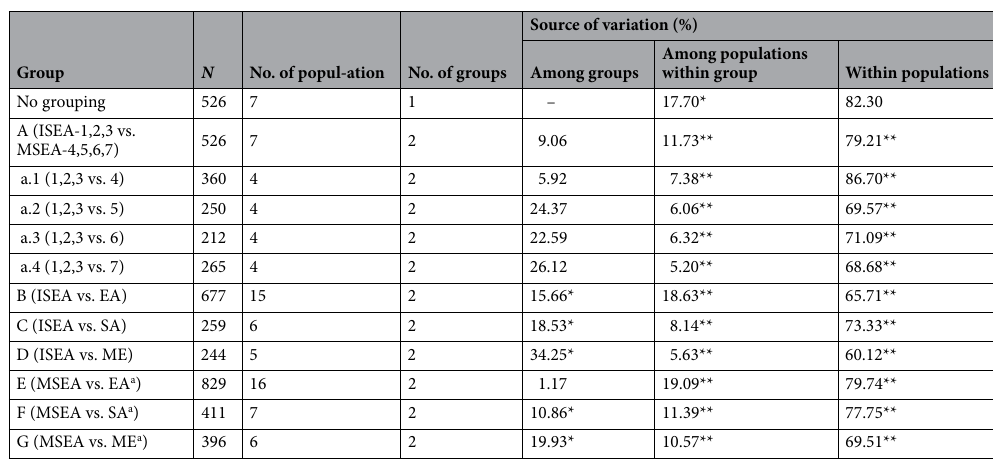
Table 2. Population genetic structure estimated from the AMOVA based on complete mtDNA D-loop sequences from (1) Philippine chickens, (2) Pacific chickens, (3) Indonesian chickens, (4) Cambodian chickens, (5) Laotian chickens, (6) Thailand chickens, (7) Myanmar chickens, and database sequences from East Asia (EA), South Asia (SA), and Middle East (ME). a Database sequences retrieved from GenBank. Significant fixation indices at * p < 0.05 ; ** p < 0.01